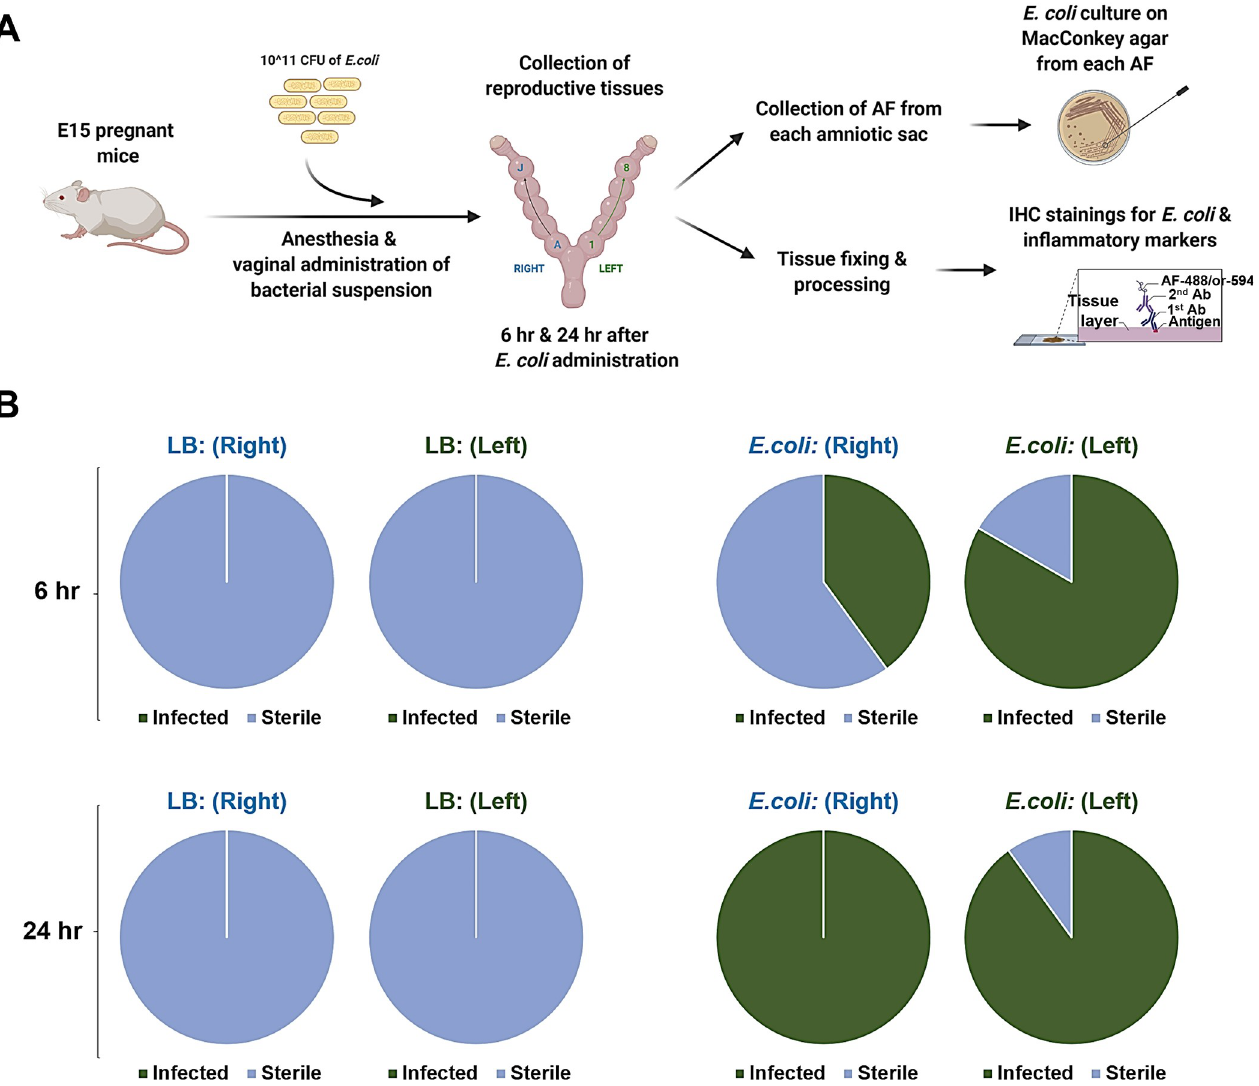
Fig 3. E . coli ascending invasion occurs in a stepwise fashion from proximal to distal embryos. ( A ) Graphic illustration of ascending infection evaluation via MacConkey agar culture and immunohistology. CFU- colony forming unit. AF- amniotic fluid. Reprinted from biorender under a CC BY license, with permission from biorender, original copyright. ( B ) E . coli culture on MacConkey agar using amniotic fluid collected from each separate embryo. Control culture shows no growth of bacteria (blue) for both 6 and 24 hr after bacterial administration. Culture of amniotic fluid from E . coli -administered (10 11 CFU) mice indicates incomplete invasion at 6 hr (half-way green) for both uterine horns (L-left, R-right) and complete invasion (full-way green) at 24 hr for both uterine horns (L and R). uterus within 6 hr. Expression of both TLR-4 and P-NF- κ B were also higher in proximal com- pared to distal horns ( Fig 5B and 5C ). Liquid broth (control) injected animal tissues remained negative for E . coli as expected with minimal levels of TLR-4 and P-NF- κ B. This is expected as a low-level inflammation is expected in these tissues on E15 and E16 as the process of labor is expected to begin around this time in this model. Fig 5D and 5F shows a similar trend in fetal membranes. E . coli reached the fetal membranes of proximal horns within 6 hr ( Fig 5D ) along with increased TLR-4 ( Fig 5E ) and P-NF- κ B ( Fig 5F ). As seen in the uterus, distal horns showed a weak staining suggesting time dependency of microbial invasion.